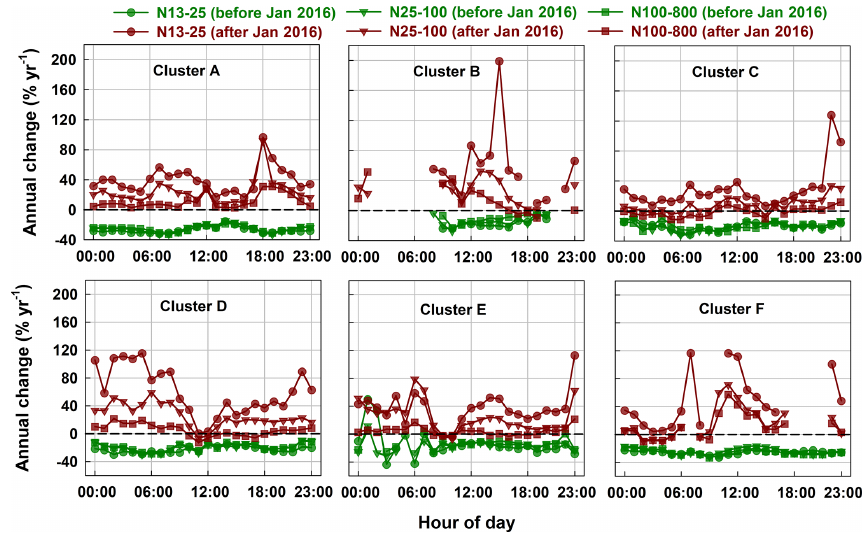
Figure 10. Diurnal variations in the trends of PNCs in three modes for the two contrasting periods (before vs. after January 2016) for each cluster. The annual change is calculated by Theil–Sen regression, and the calculation is shown in Sect. 2.4 (Trend analysis methods).